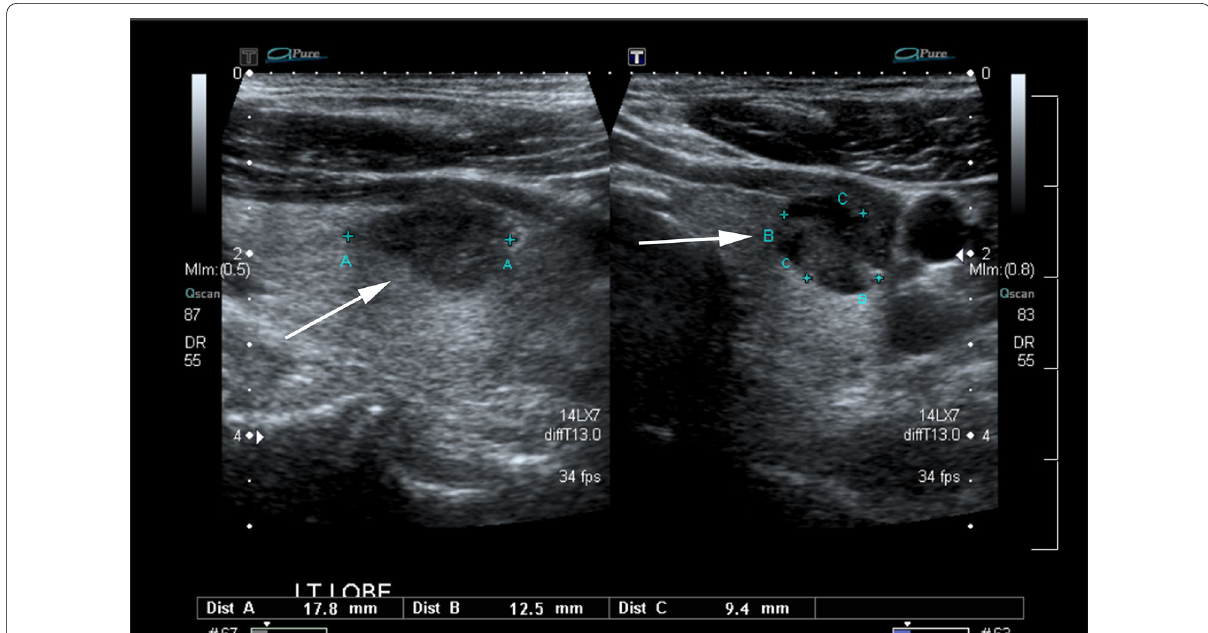
Fig. 3 46-Year-old male with 18 mm obliquely oriented PTC in left lobe of thyroid gland (arrow). The image depicts the correct three-axes technique to measure thyroid nodules described in ACR TI-RADS. Distance B illustrates the maximum dimension of the PTC on the transverse image, while distance C represents the maximum dimension perpendicular to distance B plane on the image. Note that distance B and distance C on the image are measured in the axes of the nodule and not that of the thyroid gland. Distance A depicts the maximum longitudinal image on the sagittal